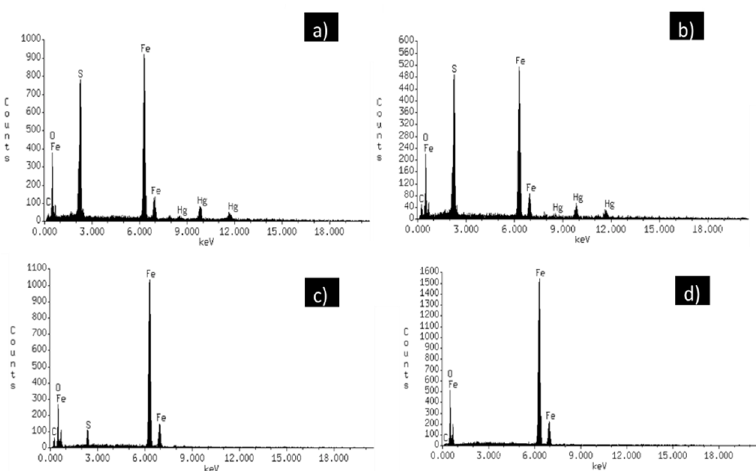
Figure 4. EDS analysis for isothermally treated samples at temperatures corresponding to each weight loss event: ( a ) first stage, ( b ) second stage, ( c ) third stage and ( d ) fourth stage.